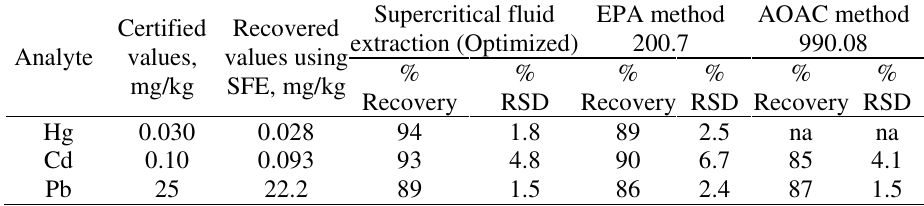
Table 3. Validation results showing the percent recoveries (accuracy) and percent RSDs (precision) of the SFE of Hg, Cd and Pb from lake sediment CRM as obtained using the optimized supercritical fluid extraction methods for metals compared with standard